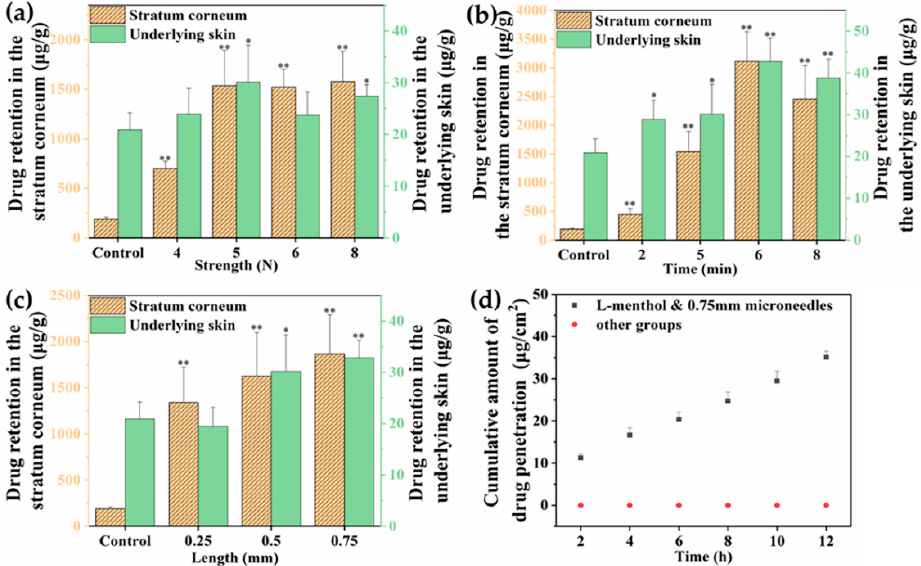
Figure 7. The content of AA in the stratum corneum and the remaining skin with the action of microneedles of ( a ) microneedles of strength; ( b ) microneedles of time; ( c ) microneedles of length; ( d ) the AA content in receptor cells in the group of the combination of L-menthol and microneedle (5 N, 6 min, 0.75 mm) and other groups including various microneedle of strength, time and length and the combination of L-menthol and microneedle (5 N, 6 min, 0.5 mm) (*: p < 0.05; **: p < 0.01).